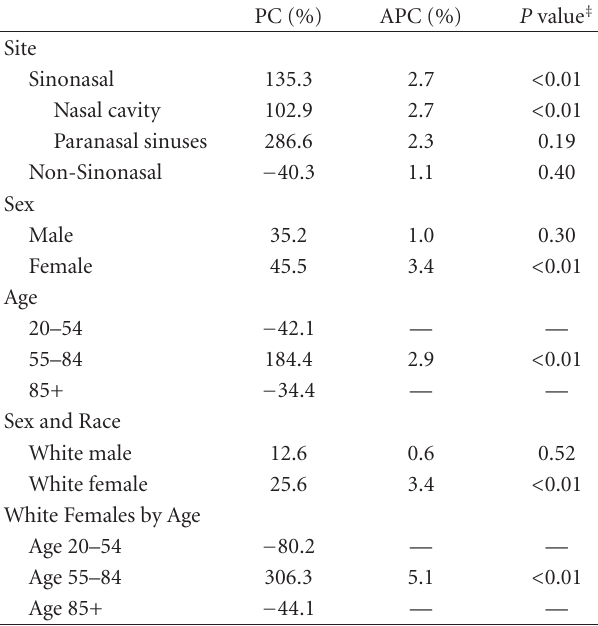
Table 2: Total percent change (PC) and annual percent change (APC) for subgroups of patients with MMHN identified in SEER 9 registries from 1987 to